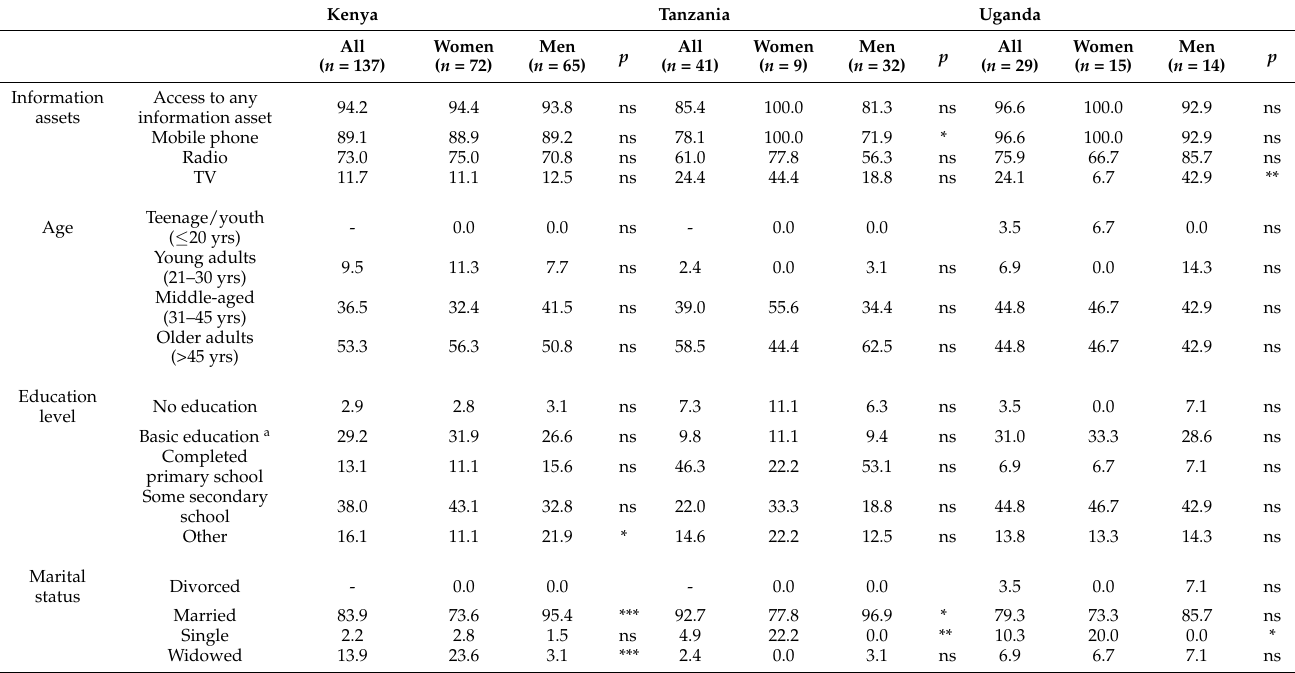
Table A6. Socio-demographic characteristics of farmers who interacted with experts by sex and country (% of